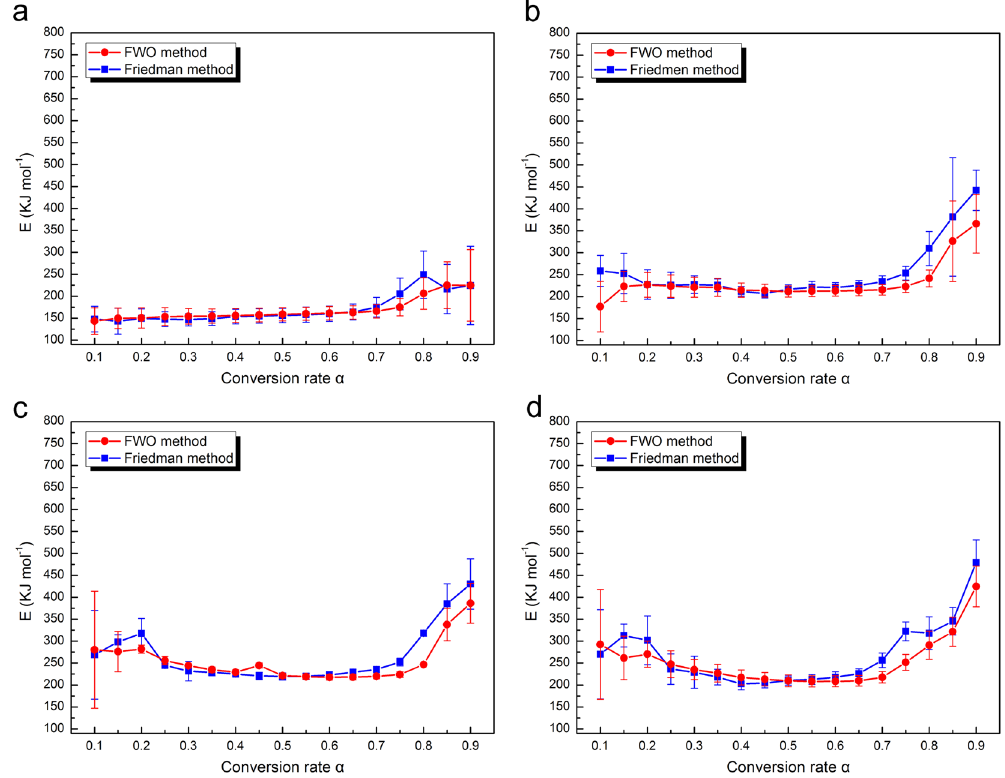
Figure 5. Activation energy (E) distribution with corresponding error bar in the different conversion rates using the FWO and Friedman methods for ( a ) PW, ( b ) MPW 1 , ( c ) MPW 2 and ( d ) MPW 3 in nitrogen